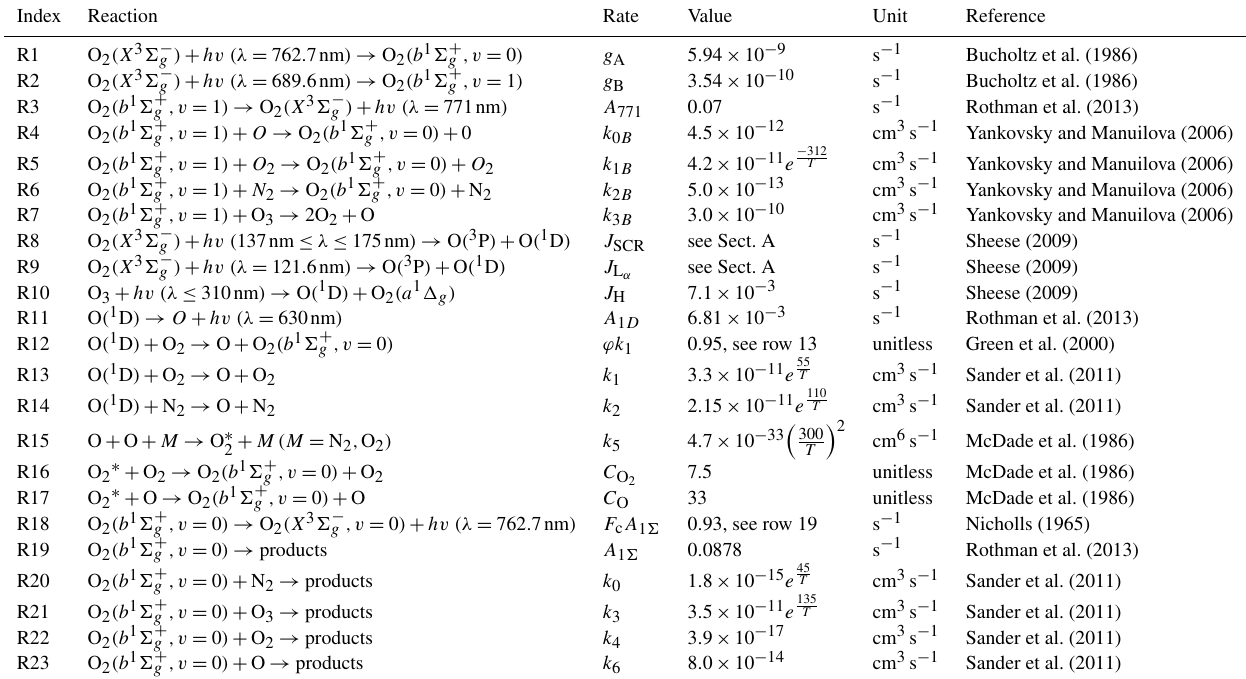
Table A1. Photochemical reaction parameters used in the simulation of the A-band production and loss mechanisms.